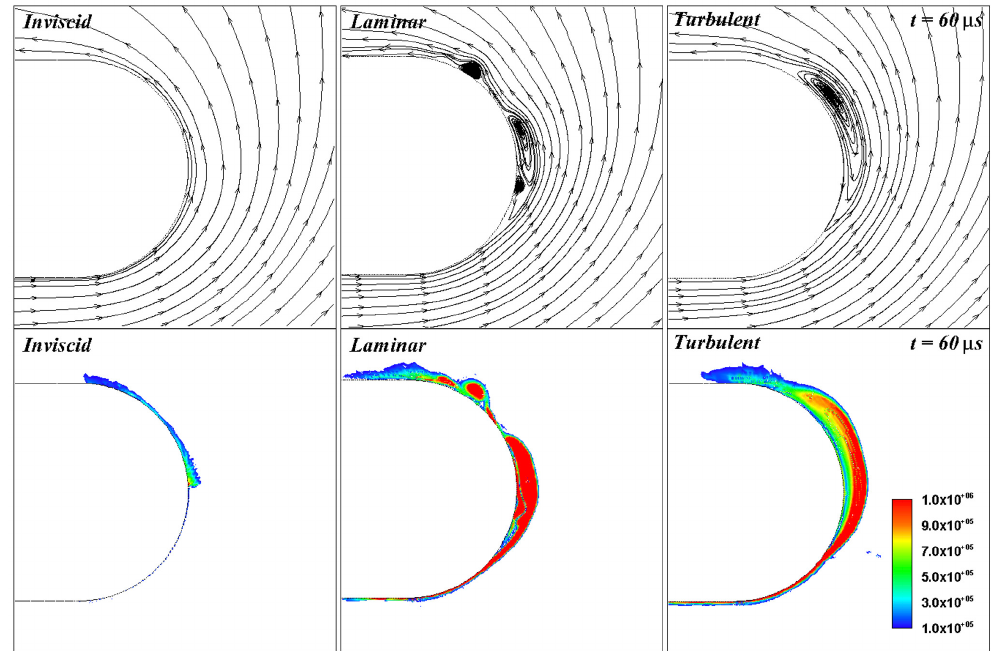
Fig. 9. Streamline (top) and vorticity (bottom) of shock wave diffraction around curved splitter corresponding to the first-raw frames of Fig. 8.